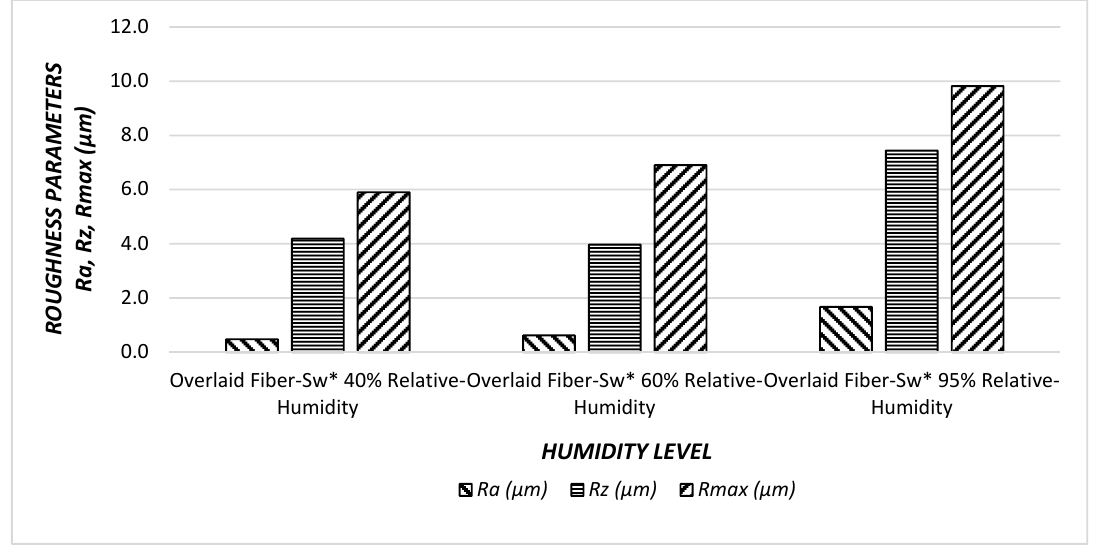
Figure 7. Surface roughness values (R a , R z , R max ) of the overlaid fiber sandwich panels (O*-Fiber Sw*) under effect of humidity.